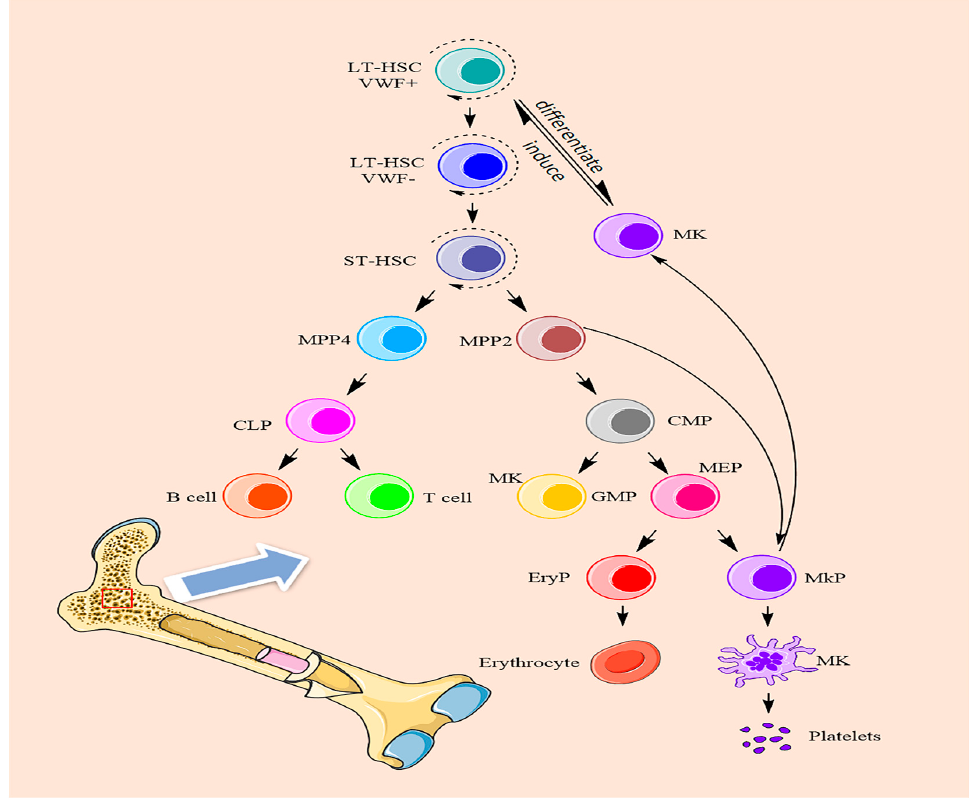
Figure 2. The differentiation processes of